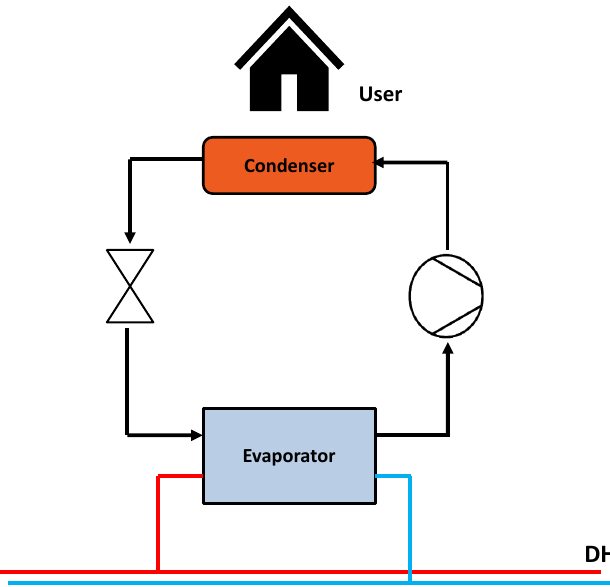
Figure 3. Distributed Heat Pump